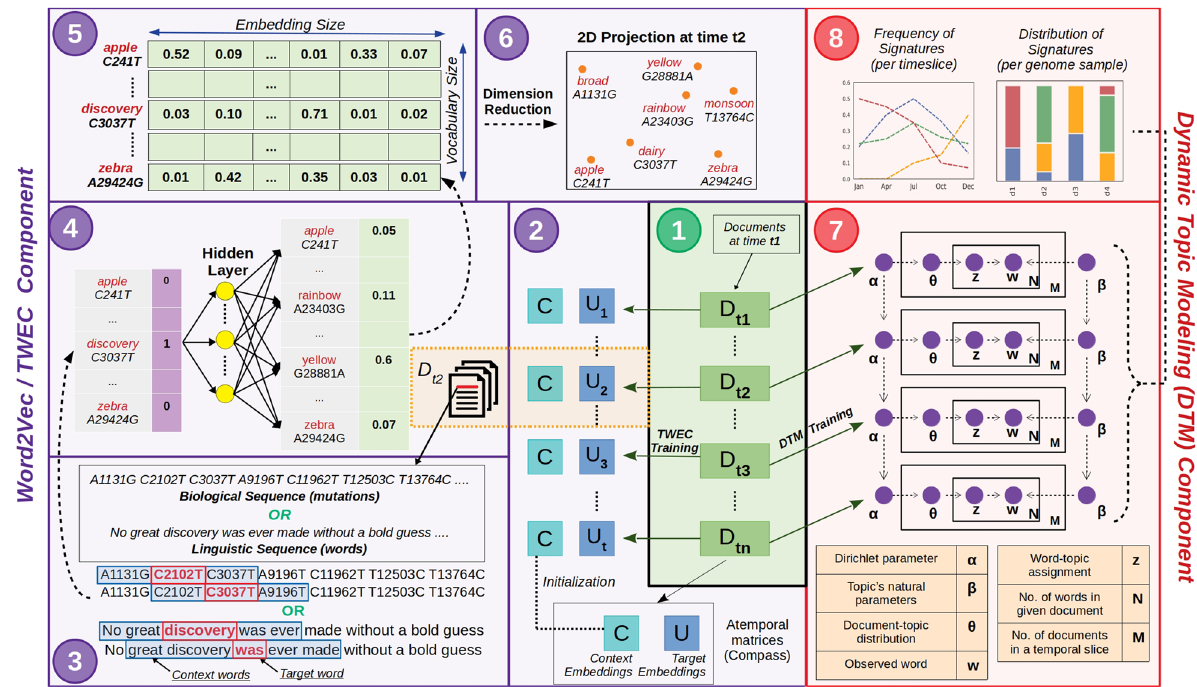
Figure 1. Graphical Summary of the entire NLP approach towards elucidating mutational signatures of genomic datasets (using SARS-CoV-2 genomes). Schematic representation of training procedure of both temporal natural language processing (NLP) approaches used in our study, i.e., Dynamic Topic Modeling (DTM) and Temporal Word Embeddings with a Compass (TWEC). Both techniques train on a collection of documents (corpus) that is split into respective time-slices. The panel description are as follows: (1) Splitting the corpus into respective time-slices: Documents (or genomes) at a particular time-slice, “tn”, is used to train DTM and TWEC models. (2) TWEC model training: Context embeddings are temporally fixed while the target embeddings are trained over each time-slice. (3) Words in each document/genome sample from time-slice t2 are iterated over sequentially. Window size (in blue) determines the span of neighbours for context consideration. (4) For each word present in time-slice t2, the embeddings are generated using Skipgram architecture of Word2vec. (5) Embedding matrix of the vocabulary (i.e., all words). (6) 2D projection of the embedding vectors generated for time-slice t2. (7) Dynamic Topic Modeling (DTM) training architecture. (8) Signature distributions are obtained for each time-slice and each